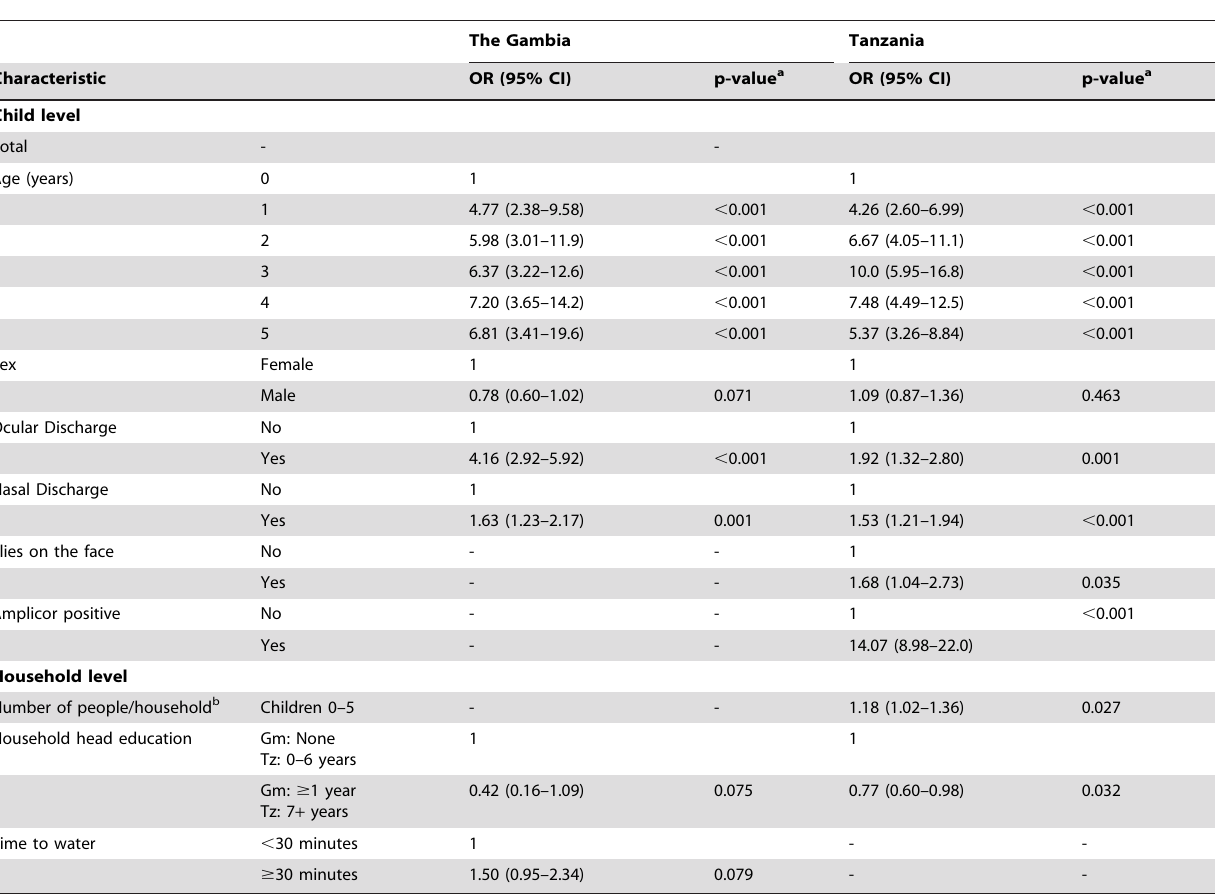
Table 4. Multivariate TF risk factor analyses in children aged 0–5 years in The Gambia and